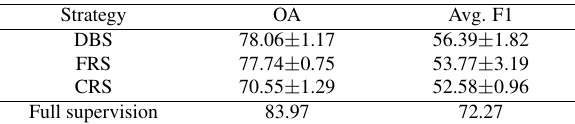
Table 3. KPConv classification